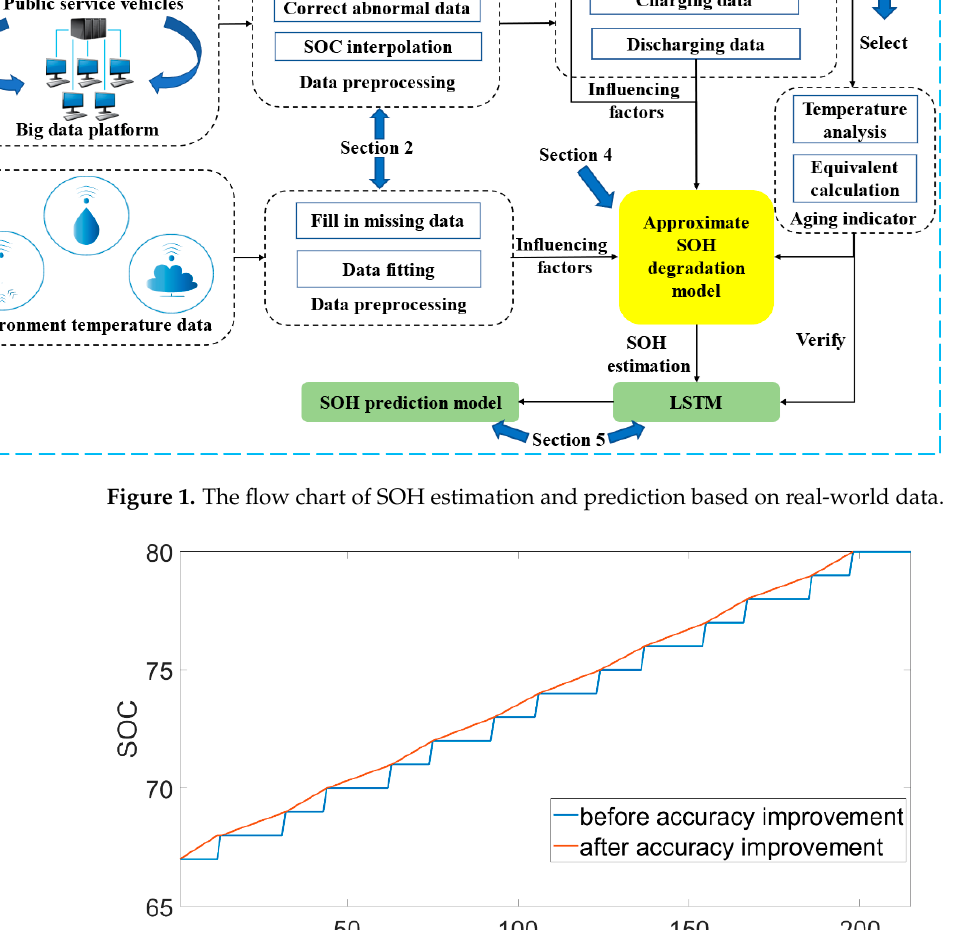
Figure 2. Comparison before and after SOC accuracy improvement. The original data were divided into charging data and discharging data. Some vari- ation parameters of charging phases and discharging phases are shown in Figures 3 and 4.